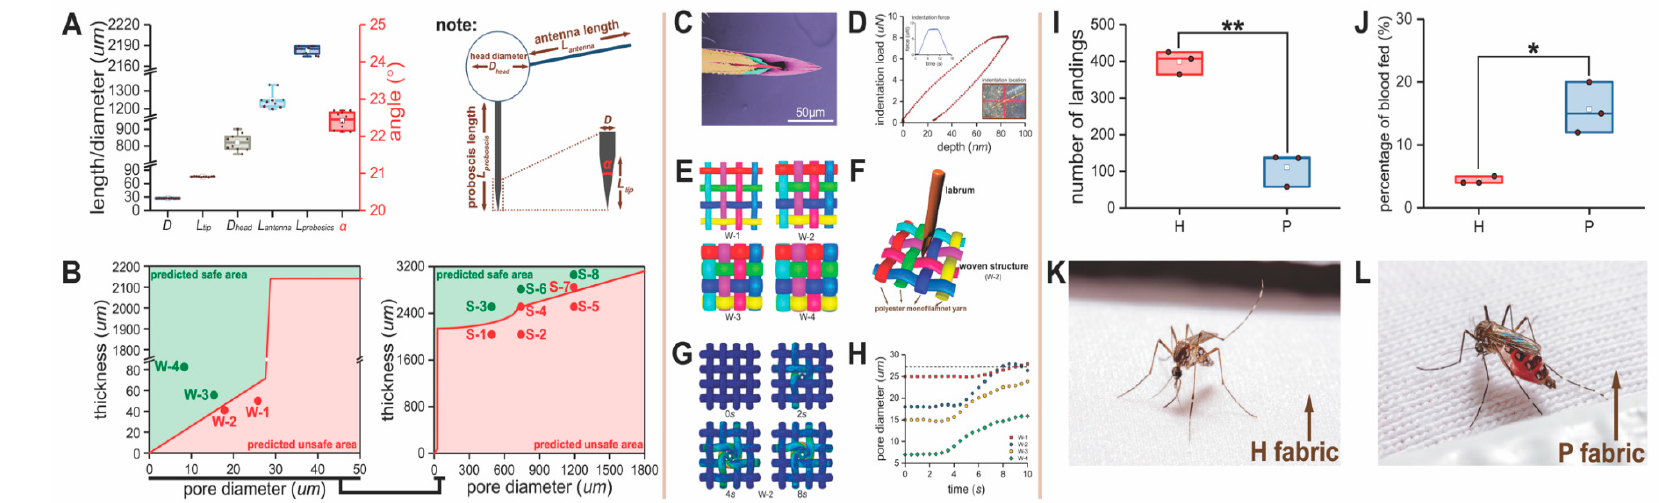
Figure 3. Mosquito morphometrics, model prediction based on mosquito morphometrics, impact of fabric distortion on biting, and comparison of non-insecticide versus insecticide-treated textiles for bite resistance. ( A ) Measured parameters of mosquito anatomy (average value calculated from 20 measurements for each parameter). ( B ) Model prediction of safe and unsafe woven filtration fabrics (left graph) and plastic plates (right graph). See Figure 4 and Table 1 for the in vitro bioassay results and Table 1 for the barrier abbreviations and whether the prediction was correct. ( C – H ) A demonstration of the textile structure failing to resist the mosquito bite at the critical boundary between safe and unsafe (Figure 3B) due to enlargement of the pore under labrum penetration. ( C ) Tip of proboscis. To measure the resistance to proboscis penetration, the mechanical property of the labrum (pink color) was measured. ( D ) Nanoindentation curve of the labrum. The elastic modulus was 1.35 GPa calculated by the load–depth curve. ( E ) Illustration of four weave patterns (W = Case 1 validating Woven structures, W1 to W4). ( F ) Model of the W2 fabric under pressure from proboscis penetration. The elastic modulus and Poisson’s ratio of the polyester monofilament used in this model was 2.16 GPa and 0.3, respectively, evaluated on the MTS ® tensile tester with 2 cm gauge and 5 mm/min speed. ( G ) Deformation process of W-2 subjected to proboscis penetration. ( H ) Variation of the pore diameter caused by proboscis penetration. The black dashed line is the maximum proboscis diameter. Pore diameters of W1 and W2 increased beyond this critical value, and thereby failed to resist proboscis penetration. ( I , J ) Arm-in-cage bioassay results for fabrics H and P: ( I ) difference in the number of landings was statistically significant at p < 0.01; ( J ) difference in the percentages of blood-fed mosquitoes was significant at p < 0.05. ( K ) Mosquitos failing to probe through the H fabric because of its small pore size (obvious proboscis bending trying to push through the H fabric). ( L ) Blood-fed female after successfully penetrating through the P fabric.